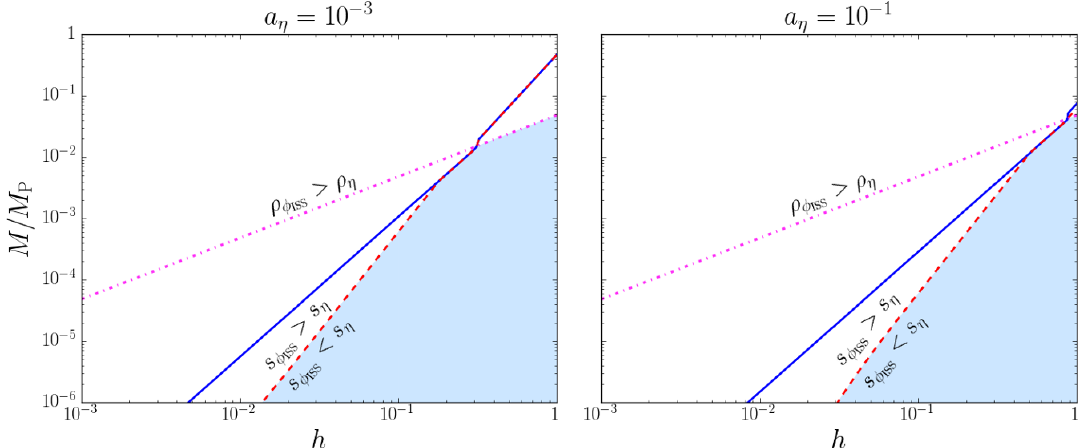
Figure 4 . The curves s (cid:30) = s (cid:17) summarizing the constraints obtained in this section | see ISS table 4 | for small (large) coupling a (cid:17) = 10 (cid:0) 3 ( a (cid:17) = 10 (cid:0) 1 ). The allowed region is shaded in blue. It also appears in section 5 with the label \sec. 4", where apart from these constraints on entropy production we also consider constraints on dark matter production. Notice that the blue shaded region should be extended to larger values of M=M P and lower values of h if the entropy of the gravitino is not considered, i.e., the red dashed curve of entropy production is less constrained and we should not consider the red dashed curve anymore. We see in section 5 when this turns out to be the